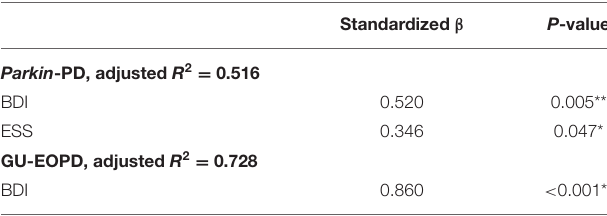
TABLE 4 | Main determinants of QoL in PD- Parkin and GU-EOPD patients. Standardized